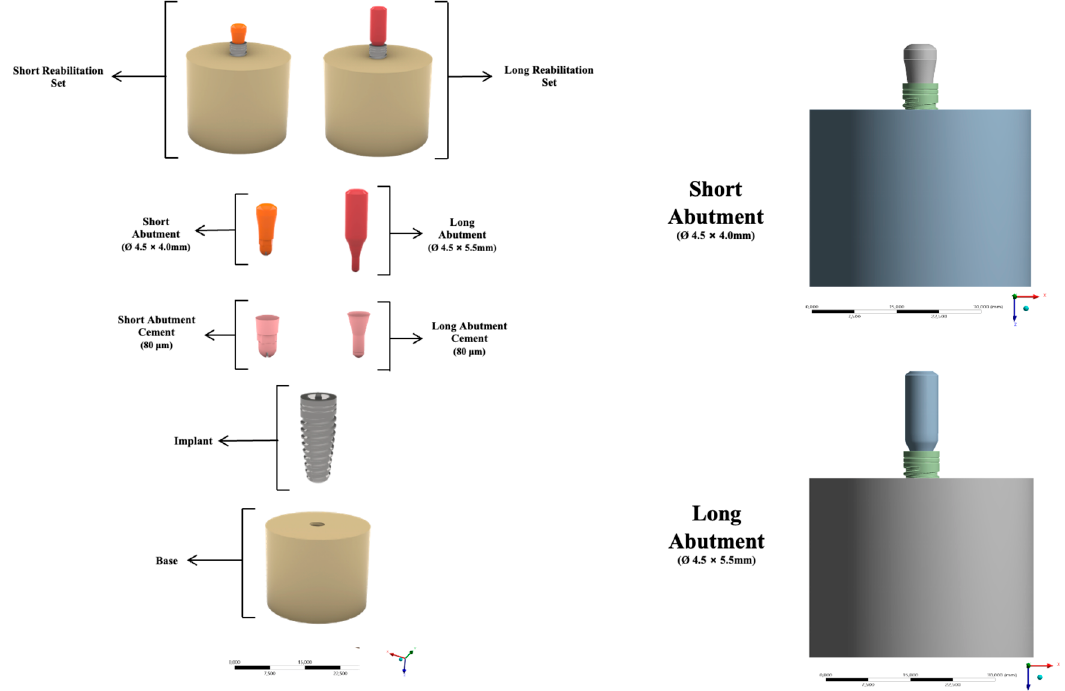
Figure 1. Illustrative of 3D models following the clinical sequence of an implant-supported prosthesis using the short abutment and long abutment implant